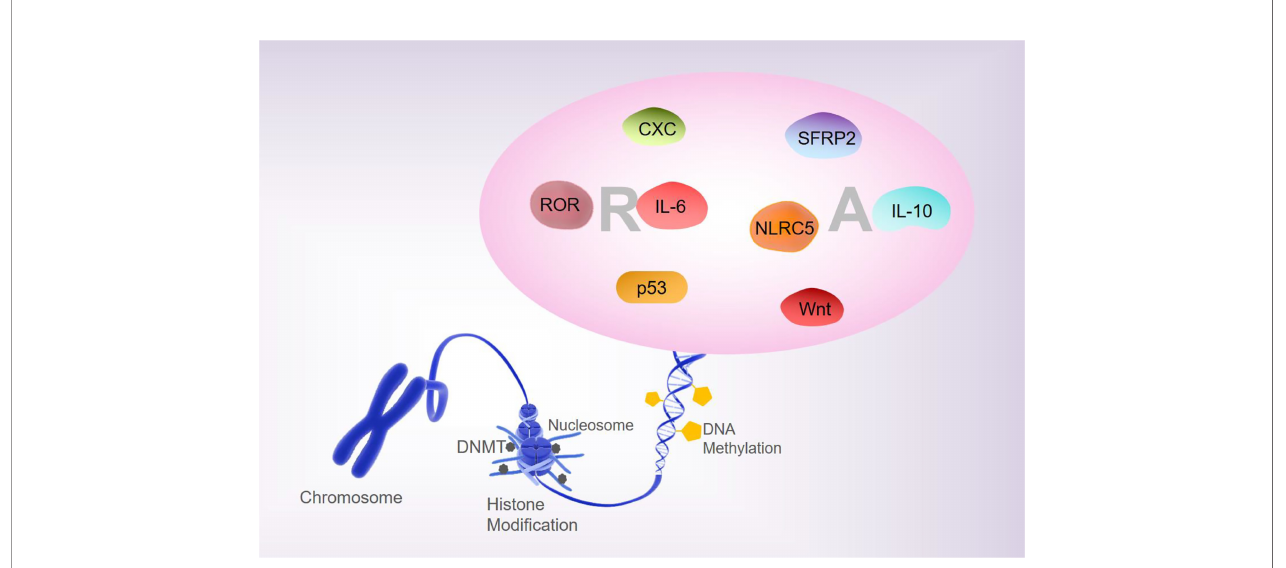
FIGURE 1 | DNA methylation and RA. Changes in the methylation status of RA-related are involved in regulating the pathogenesis and progression of